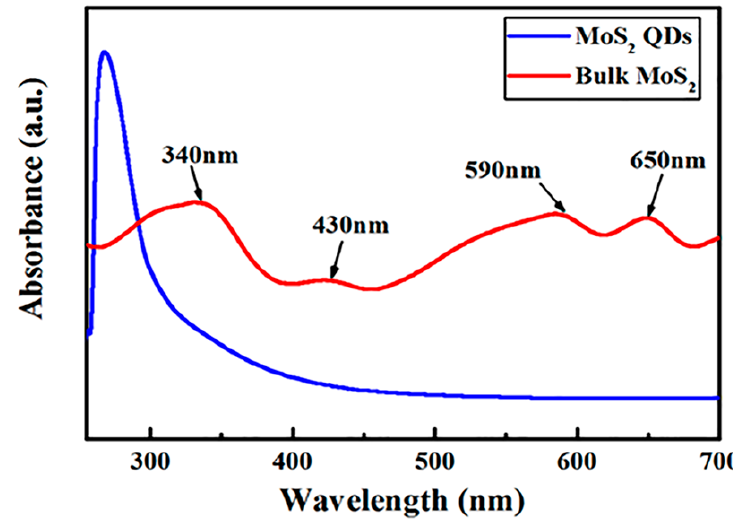
Figure 7. UV–Vis spectra of MoS 2 in both bulk and quantum dot forms synthesized from femtosecond laser ablation. Reproduced with permission from [48] under a Creative Commons license.